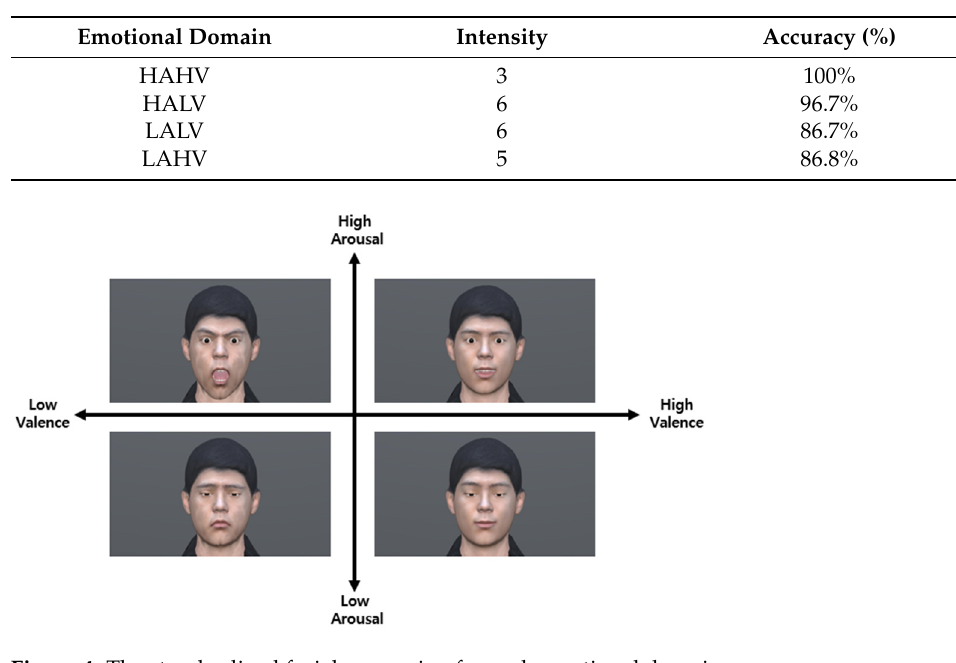
Figure 4. The standardized facial expression for each emotional